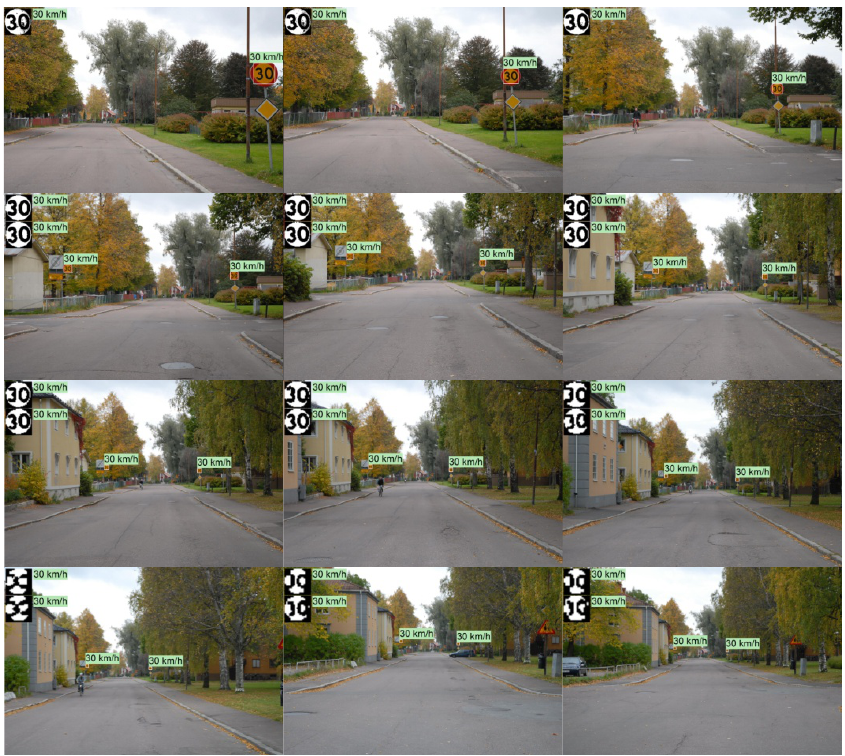
Figure 9. Classification of speed limit traffic sign on different distances. Top Left: 10 m distance, Bottom Right: 120 m distance. Images are taken in 10 m step. different positions in the image and the size of these traffic signs changed by the distance. This illustrates the invariance of the proposed approach to the translation and